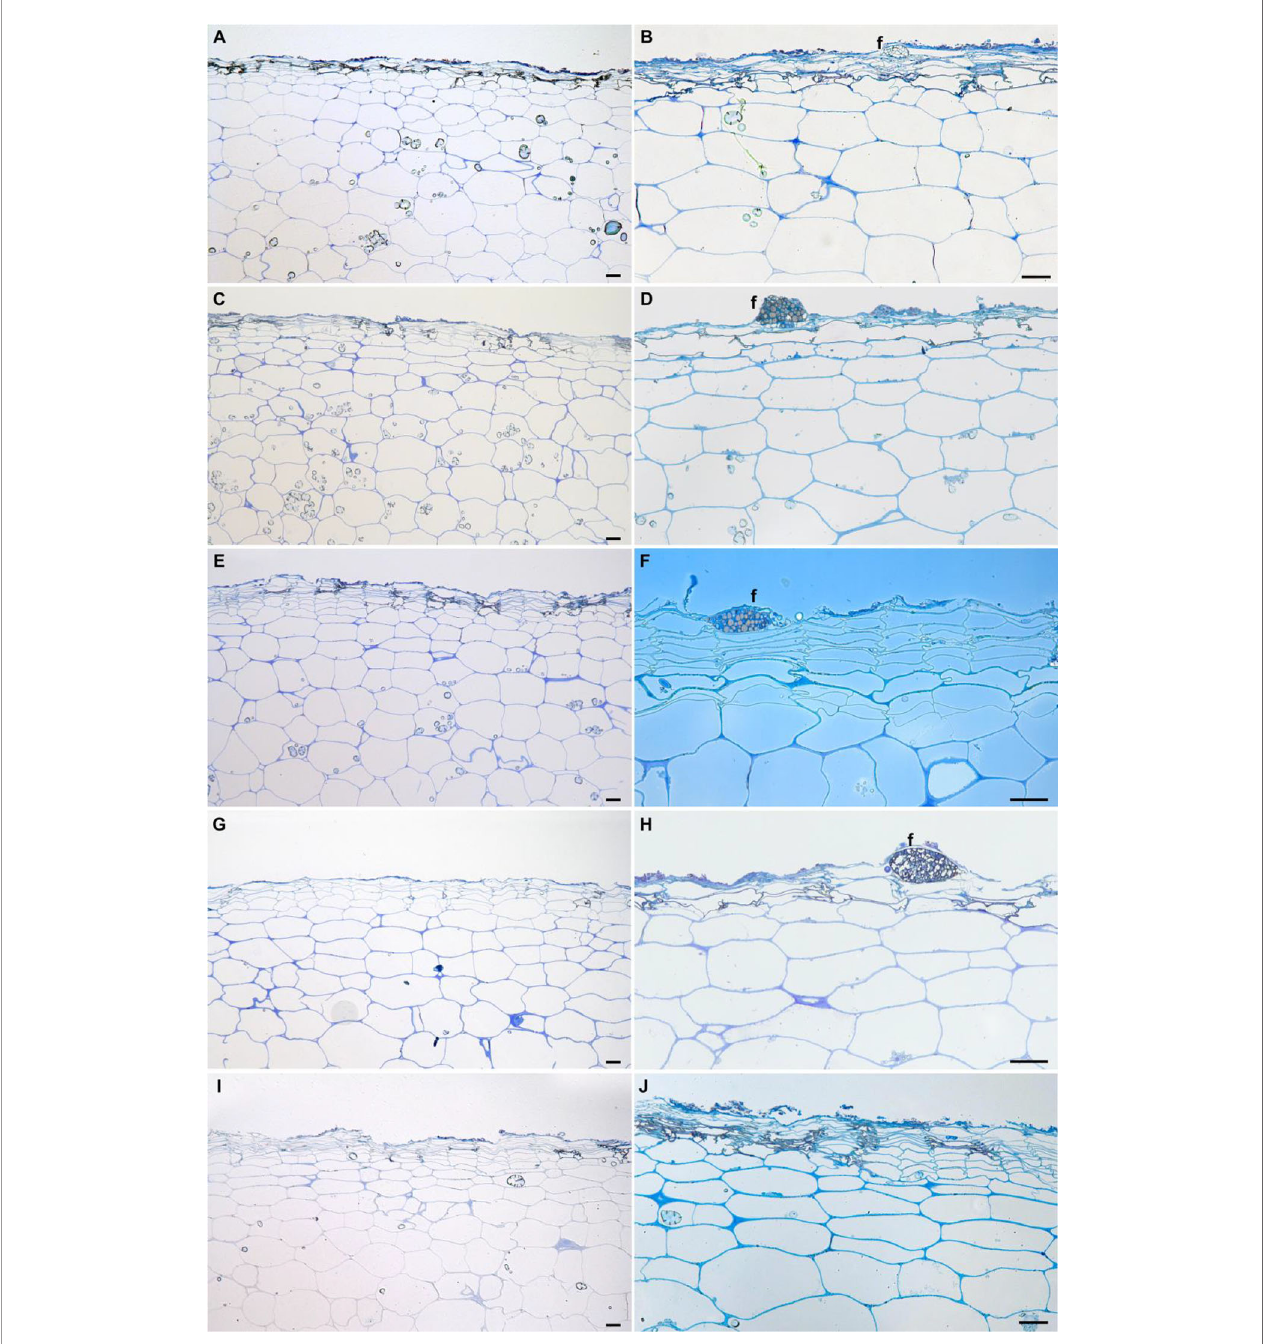
FIGURE 3 | Longitudinal semithin sections of the phelloderm of asymptomatic (A , C , E , G , I) and black dot symptomatic (B , D , F , H , J) regions of the fi eld-grown potato cultivars Lady Felicia (A , B) , Lady Christl (C , D) , Cheyenne (E , F) , Gwenne (G , H) , and Erika (I , J) . Bars correspond to 50 µm. f : fungal